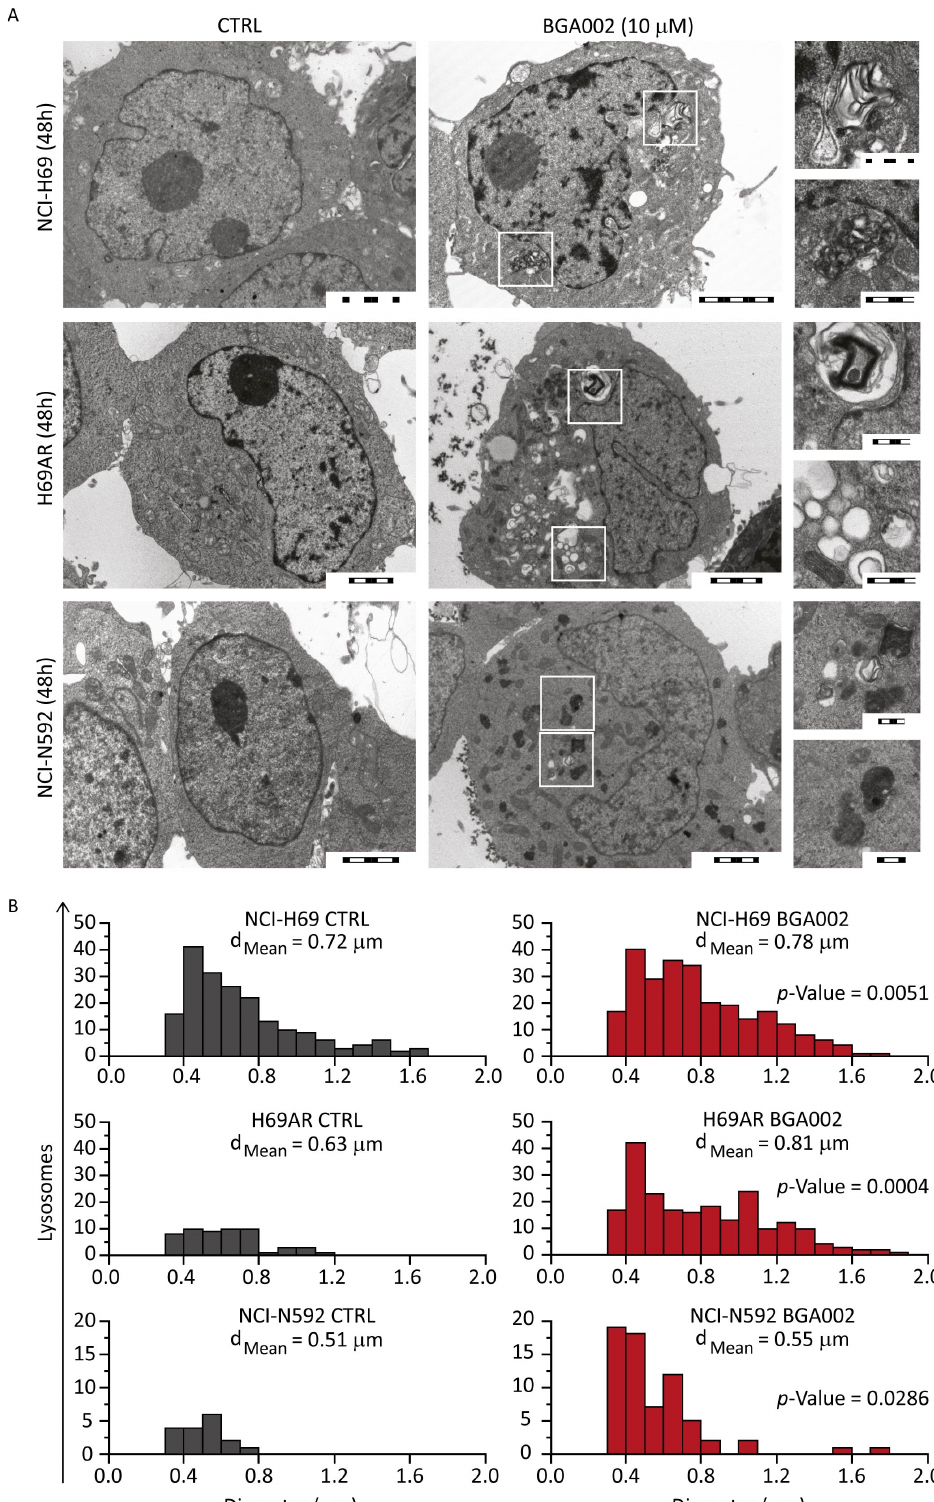
Figure 2. BGA002 modifies lysosome morphological characteristics and distribution in SCLC cell lines. ( A ) Electron microscopy image of SCLC cell lines untreated or treated with BGA002 10 μ M for 48 h. Magnification highlights lipid degradation structures and vesicle formations. Scale bar in the whole cell images correspond to 2 μ m; scale bar on the magnifications correspond to 500 nm. ( B ) Distribution of lysosome diameters acquired with confocal microscope, in SCLC cell line, untreated (left) or treated (right) with BGA002 for 48 h. Lysosome data for each cell (n = 40) are analyzed with two tailed, paired Student’s t -test. Mean lysosome diameter is reported for each cell line.